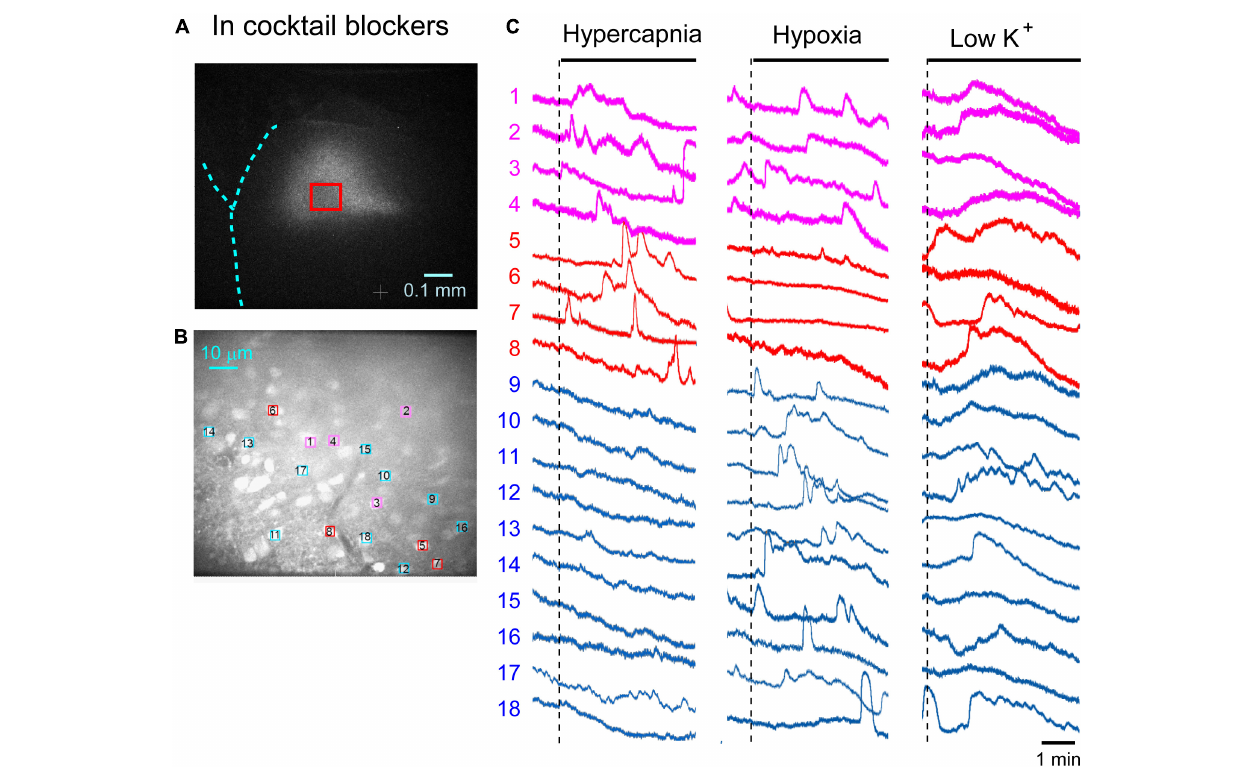
FIGURE 3 | Calcium imaging in the NTS in cocktail blockers solution. (A) Low-magnification image of the cut surface where Oregon Green was injected and calcium imaging was performed. (B) Optical image of the cut surface stained with Oregon Green. The red square in (A) corresponds to the measured area shown in (B) . (C) Calcium signals plotted as fluorescence intensity in identified NTS cells numbered in the image in (B) in response to hypercapnia (left), hypoxia (middle) and low K + (right) stimulation. Magenta traces denote calcium signal intensity of cells (Nos. 1–4) responding to stimulation of both hypercapnia and hypoxia. Red traces denote calcium signal intensity of cells (Nos. 5–8) responding only to hypercapnia. Blue traces denote calcium signal intensity of cells (Nos. 9–18) responding only to